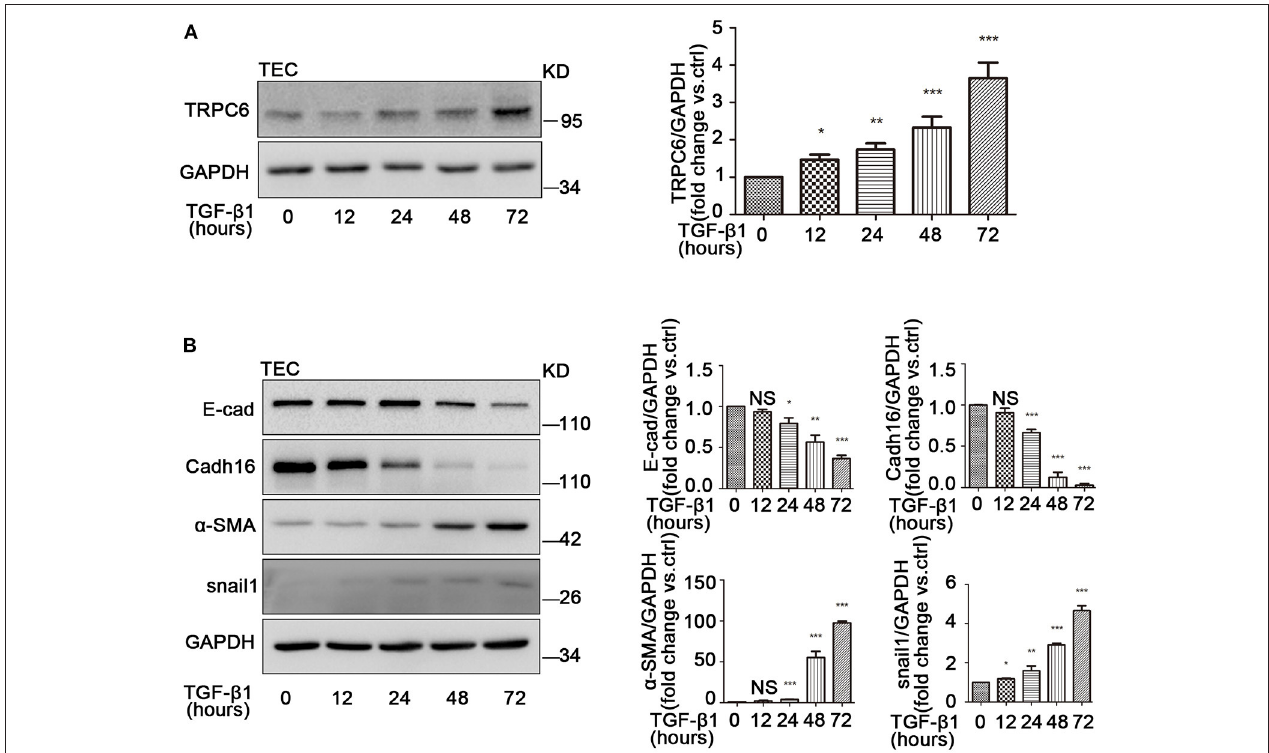
FIGURE 3 | The increase of TRPC6 and activation of EMT in primary TEC stimulated with TGF- β 1. (A) Expression of TRPC6 in primary TEC without and with TGF- β 1 (5ng/ml in 20mM citric acid, pH 3.0) stimulation at 12, 24, 48, and 72h detected by western blot. Data are presented as mean ± sem, n = 3; an unpaired two-tailed t -test was used. * P < 0.05, ** P < 0.01, *** P < 0.001. (B) Relative expression of the EMT markers including E-cad, Cadh16, α -SMA, and snail1 in primary TEC with and without TGF- β 1 stimulation for 72h detected by western blot. Data are presented as mean ± sem, n = 3; an unpaired two-tailed t -test was used. NS,